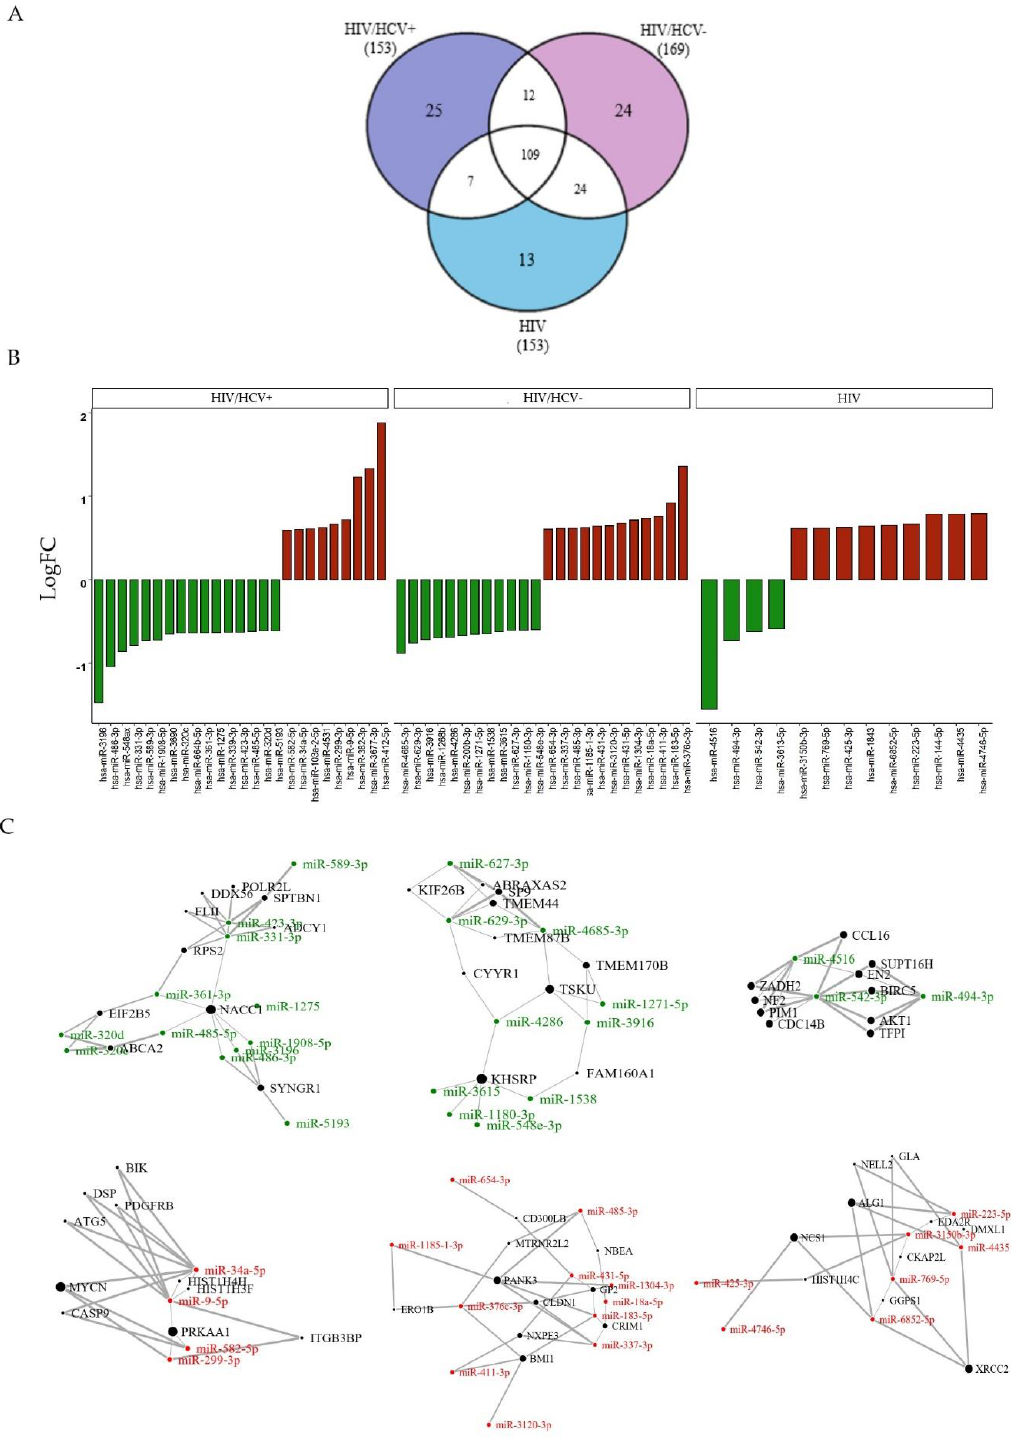
Figure 3. Analysis of specific viral infection signature due to HIV/HCV+, HIV/HCV- or HIV infection: ( A ) Venn diagram representing the distribution of shared and non-shared significant differentially expressed SDE miRNAs among each HIV group (colorless and colored areas, respectively). ( B ) Bar plot of the fold change of non-shared SDE miRNAs ( x -axis) in the log 2 scale ( y -axis). Downregulated and upregulated miRNAs are presented as green and red bars, respectively. ( C ) Network graph of the top 10 target genes (black nodes) and their SDE miRNA interactor partners (green/red nodes) for each analysis. Down or upregulated miRNAs in HIV patients have been colored in green and red, respectively. The thicker the line connecting SDE miRNAs to their target gene the more significant the interaction, and the wider the radius the greater number of interactions for each target